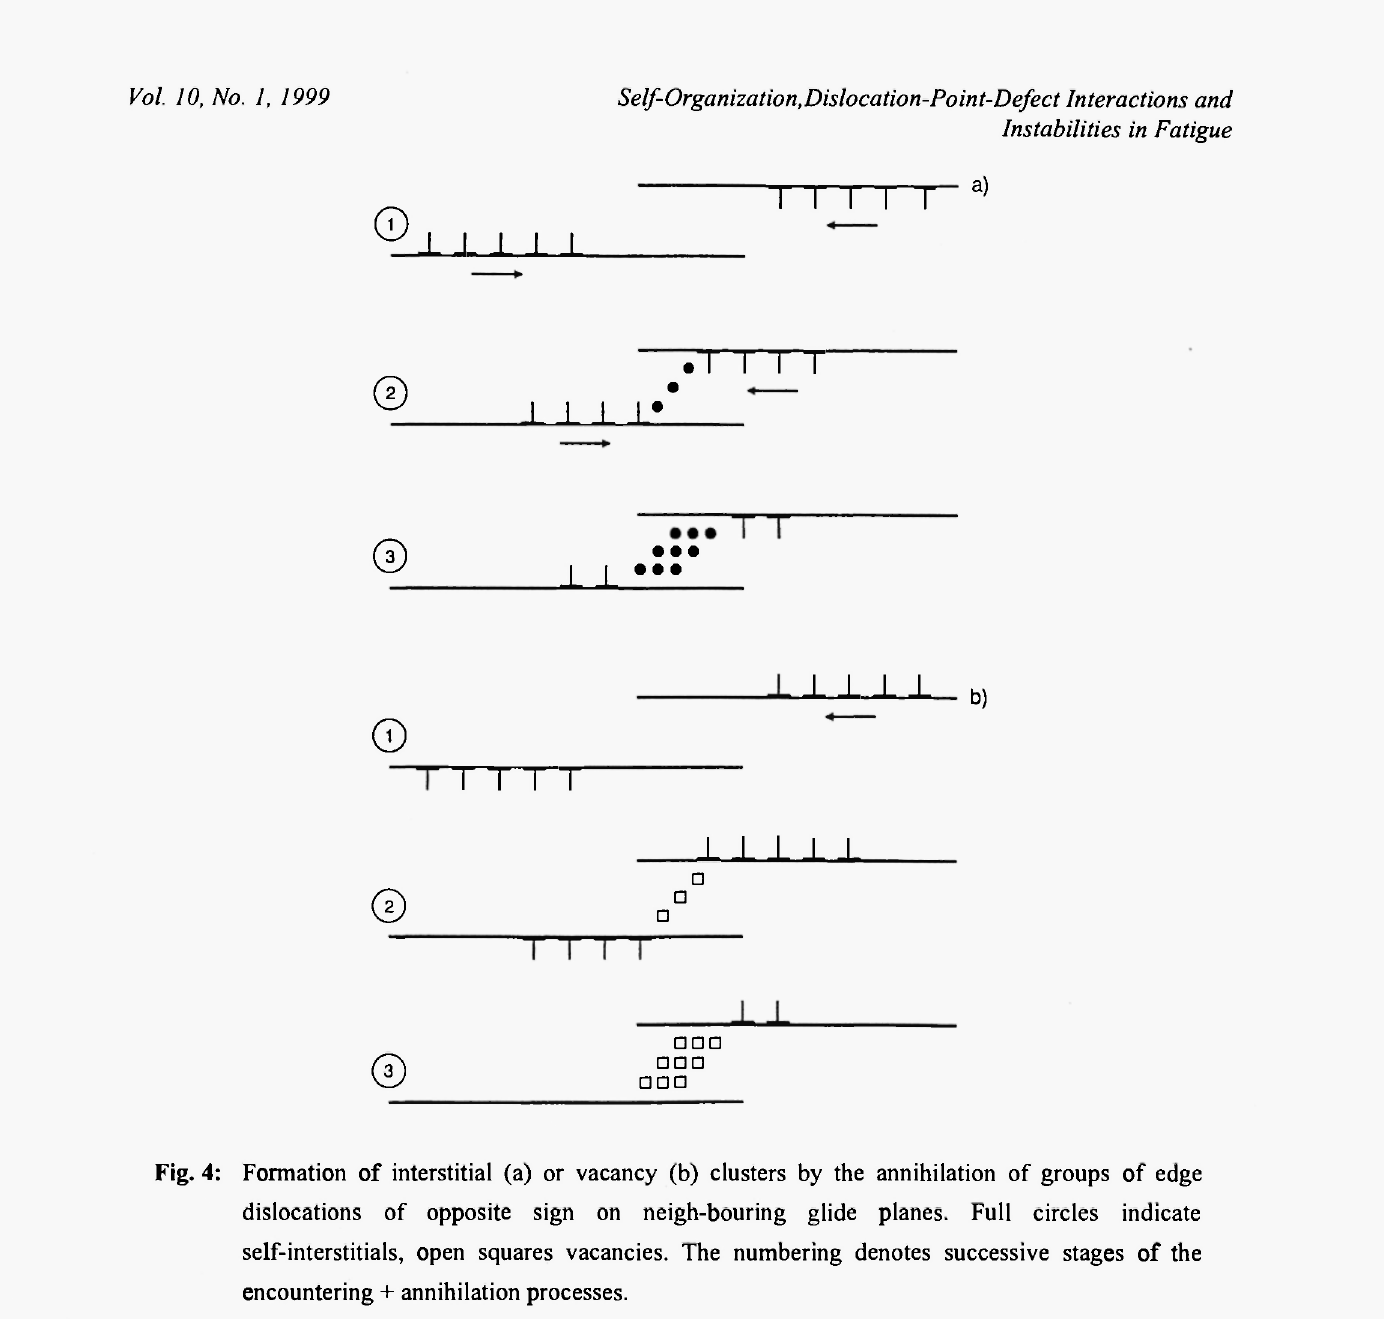
Fig. 4: Formation of interstitial (a) or vacancy (b) clusters by the annihilation of groups of edge dislocations of opposite sign on neigh-bouring glide planes. Full circles indicate self-interstitials, open squares vacancies. The numbering denotes successive stages of the encountering + annihilation